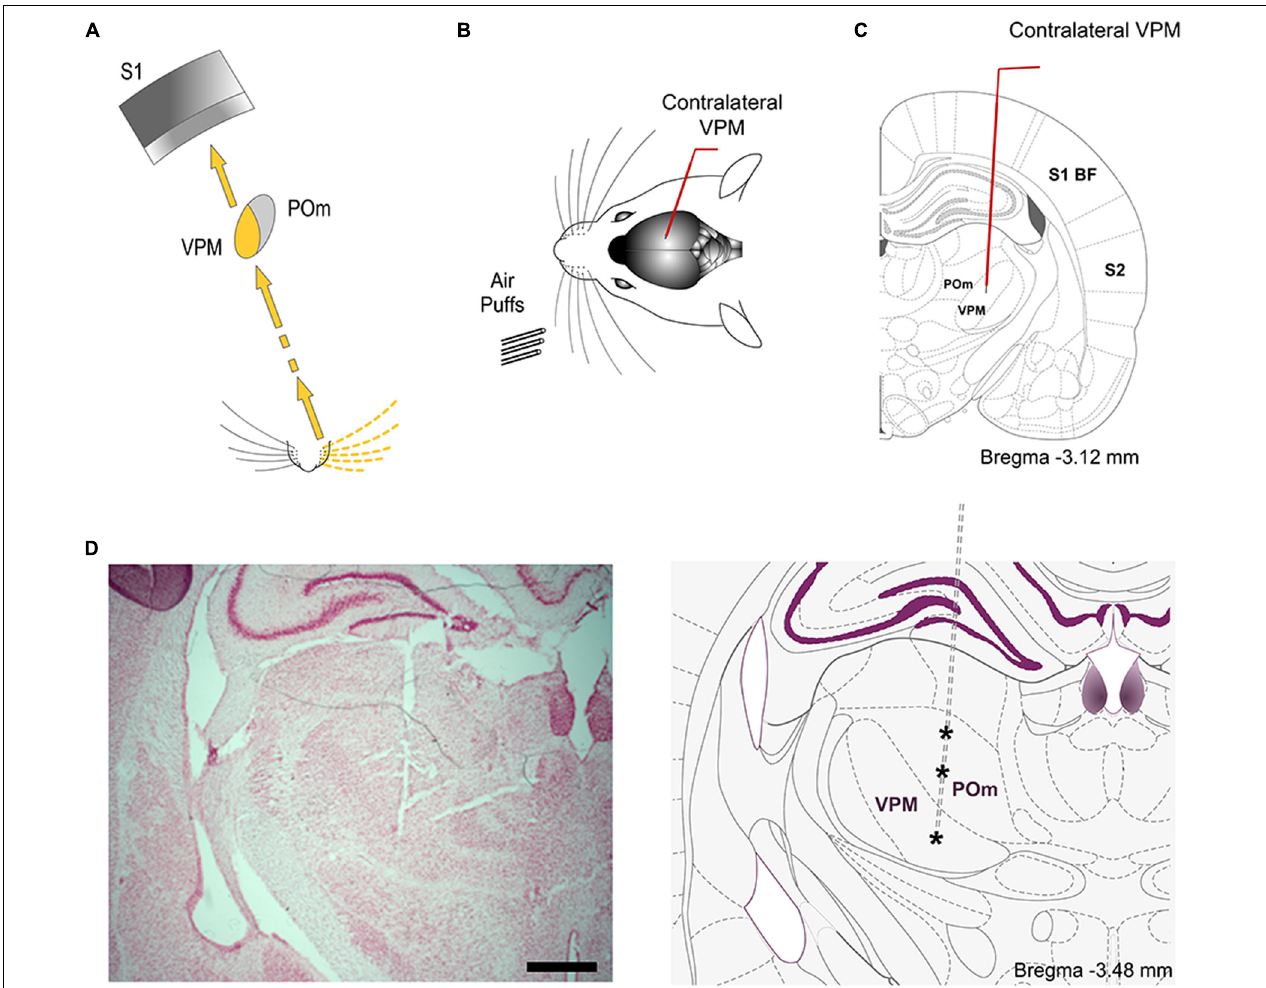
FIGURE 6 | VPM. (A) Schematic illustration of the lemniscal pathway. (B) Schematic drawing displaying the sensory stimulation via patterns of multiwhisker deflections. Recordings were made in the contralateral VPM nucleus. (C) Coronal section illustrating a recording electrode inserted into the VPM. (D) The left panel shows a representative Nissl stained coronal section displaying the location of the sequence of recording sites (indicated by asterisks in the other panel) in POm and VPM and the track left by the electrode. An atlas schematic reconstruction of this coronal section is shown in the right panel (Paxinos and Watson, 2007). Scale bar, 1